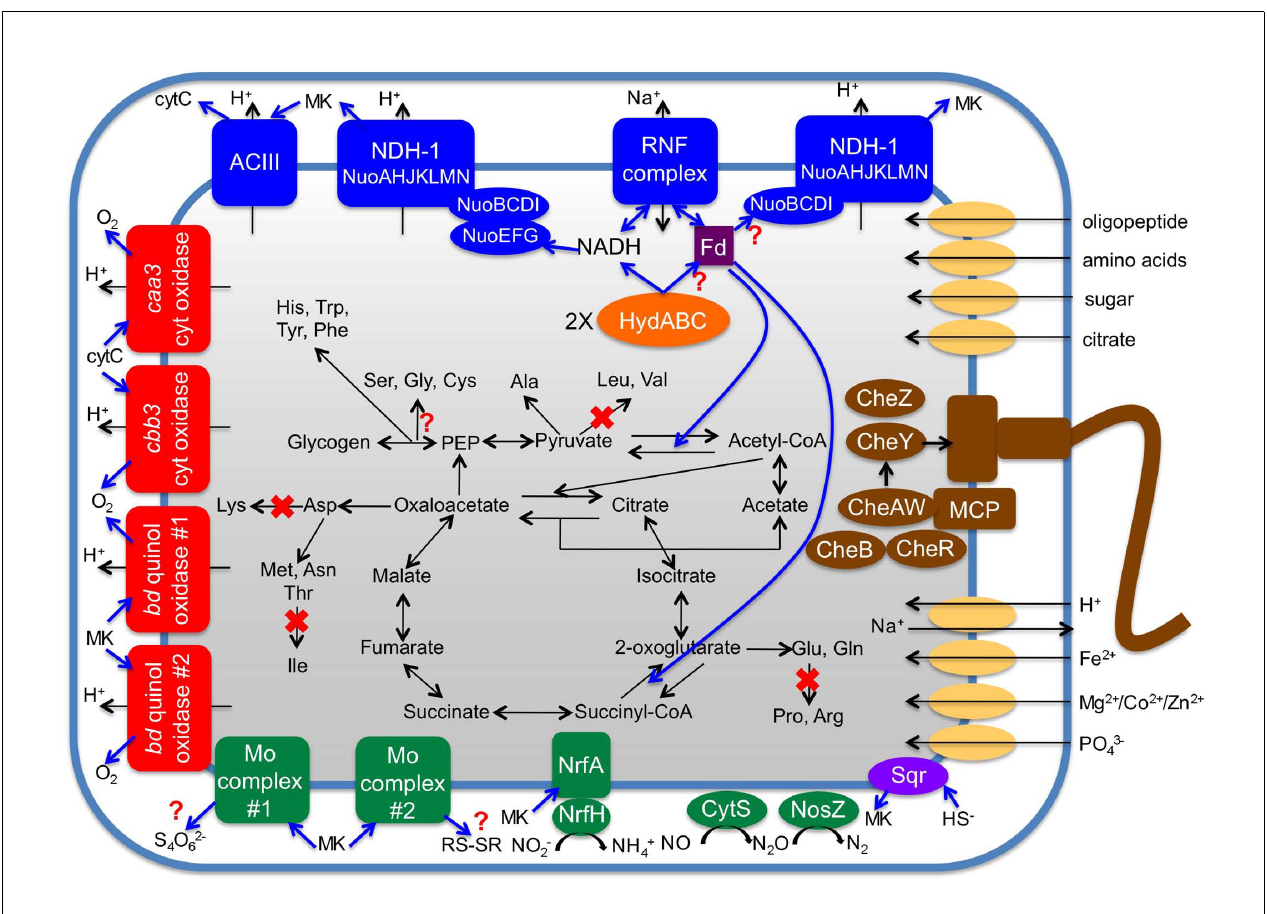
type-1 NADH dehydrogenase; Fd, ferredoxin; MK, menaquinone; cyt, cytochrome; Mo complex, complexes containing a molybdopterin-guanine dinucleotide cofactor; ACIII, alternative complex III.